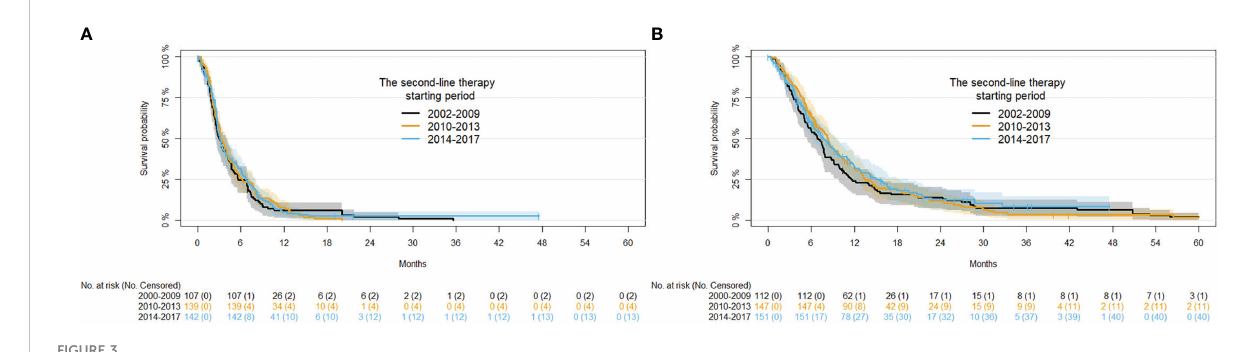
Age at second-line